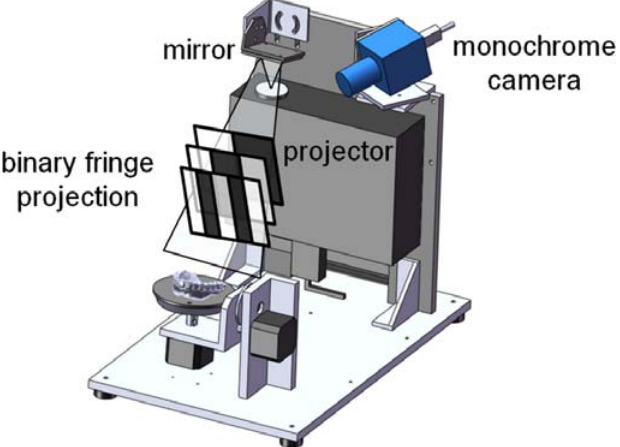
Figure 2. Scheme of the assembled optical dental